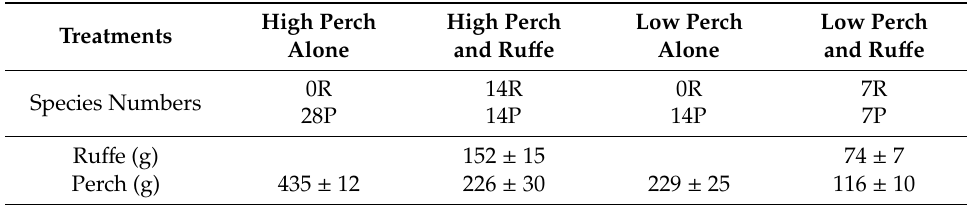
Table 3. Mean total biomass ± 95% C.I. of ru ff e (R) and yellow perch (P) in treatments of the 1996 ru ff e and fish density experiment. There were four replicates of each treatment. High Perch High Perch Low Perch Low Perch Treatments Alone and Ru ff e Alone and Ru ff